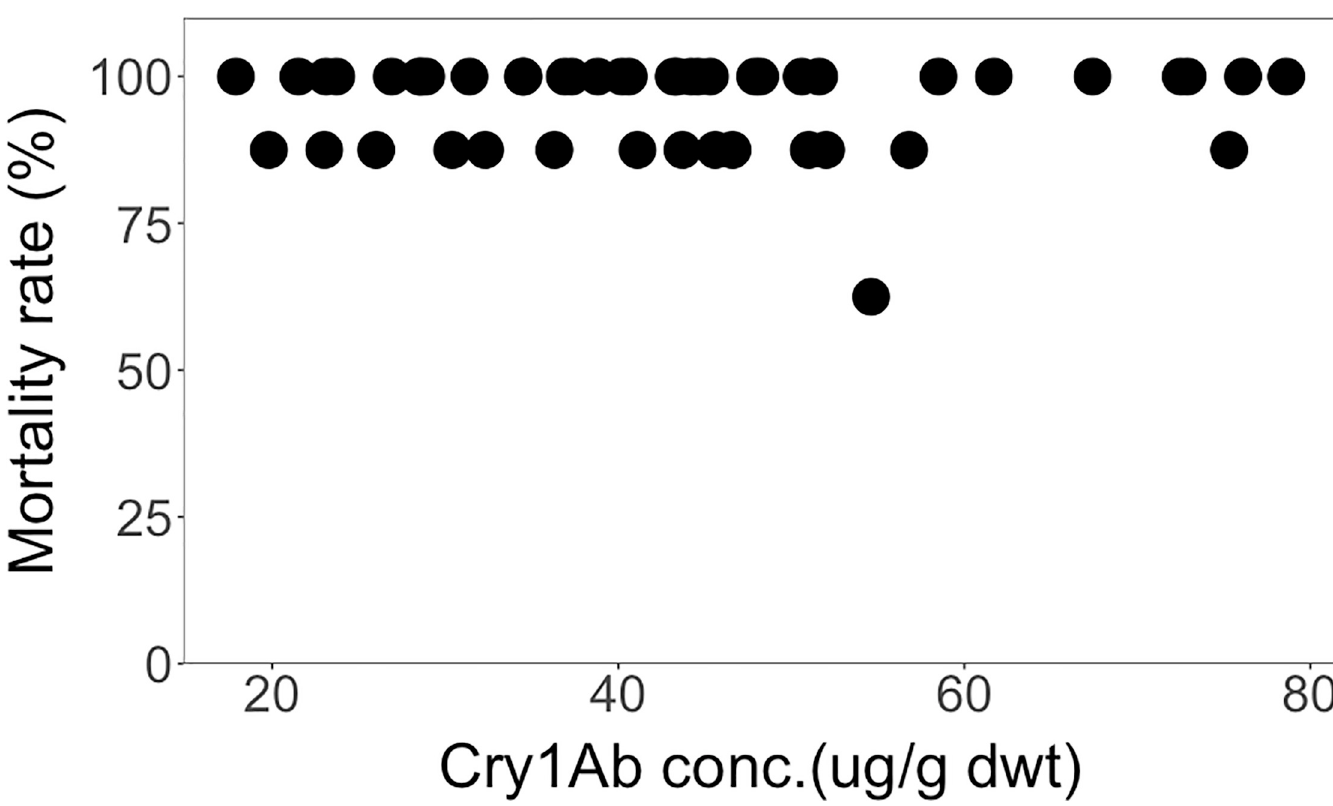
Fig 9. Spearman rank correlation between mortality rate and Cry1Ab concentrations across different genetic backgrounds from Brazil. ( Rs = -0.01, P = 0.929).